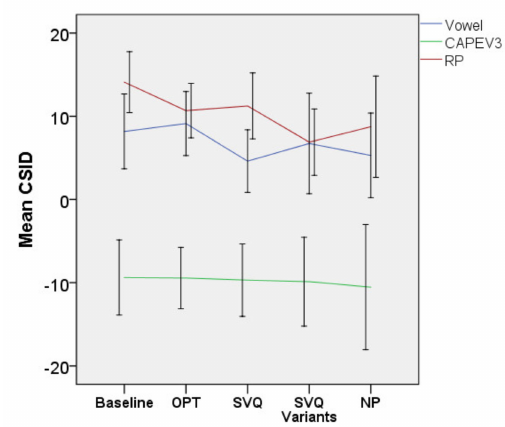
Figure 9. Mean CSID of all vocal tasks. Error bars indicate 95% CI for the mean. Abbreviations: CAPEV3, third CAPEV phrase and RP, Rainbow Passage.